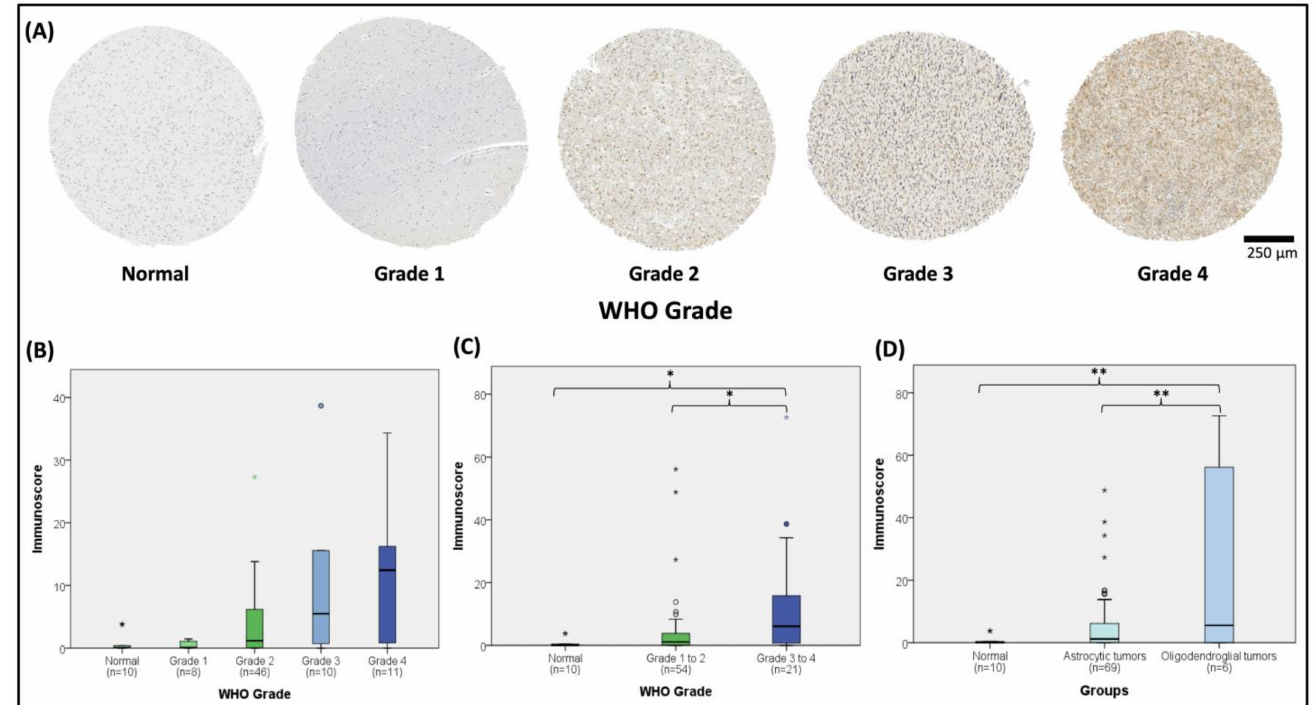
Figure 3. Immunohistochemical (IHC) anti-GRPEL2 staining of normal brain and gliomas with histological validation of TCGA/CGGA results. ( A ) The top panel displayed IHC-stained sections showing normal (non-neoplastic) brain, grade 1 (Gr-I), grade 2 (Gr-II), grade 3 (Gr-III) and grade 4 (Gr-IV) glioma tissues (from left to right). ( B ) showed elevated GRPEL2 protein staining (by immunoscore) significantly associated with WHO grades of gliomas (* p < 0.05), and the number for each grade was shown in parentheses. ( C ) showed elevated GRPEL2 protein staining (by immunoscore) correlated with higher-grade gliomas (grades 3 to 4) rather than lower-grade gliomas (grades 1 to 2) (* p < 0.05) ( D ) Elevated GRPEL2 protein staining (by immunoscore) was enhanced with oligodendroglial differentiation among histologically defined astrocytic tumor and gliomas with an oligodendroglial component (** p < 0.01). Note that GRPEL2 staining is greater at higher tumor grades. Scale bar in 250 µ